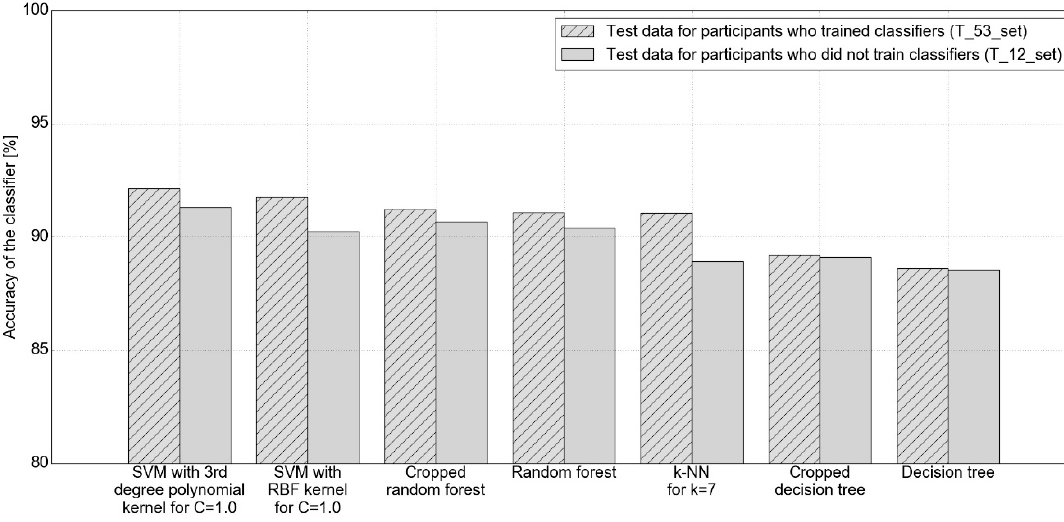
Figure 5. Comparison of the classifiers’ accuracy obtained for the test data from participants who trained classifiers on the T_53_set and the test data from individuals who did not record the training data (T_12_set). Classifiers accuracy for the test data—causal system (vectors with 42 parameters).